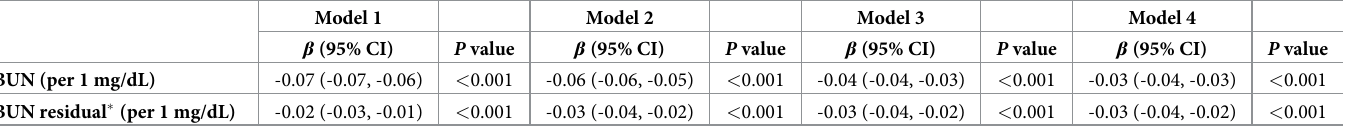
Model 1: Unadjusted Model 2: Adjusted for age, sex, smoking, SBP, DM, HTN, CCI Model 3: Model 2 + adjustment for eGFR, log UPCR, WBC, platelet, log CRP, albumin, total cholesterol, log ferritin, log hepcidin, iron, and TSAT Model 4: Model 3 + adjustment for use of iron replacement therapy, ESA, ACEi or ARB, statin, and diuretics. BUN, blood urea nitrogen; SBP, systolic blood pressure; DM, diabetes mellitus; HTN, hypertension; CCI, Charlson comorbidity index; eGFR, estimated glomerular filtration rate as determined by the CKD-EPI creatinine equation; WBC, white blood cell; UPCR, urinary protein-to-creatinine ratio; CRP, C-reactive protein; TSAT, transferrin saturation; ESA, erythropoiesis-stimulating agent; ACEi, angiotensin converting enzyme inhibitor; ARB, angiotensin II receptor